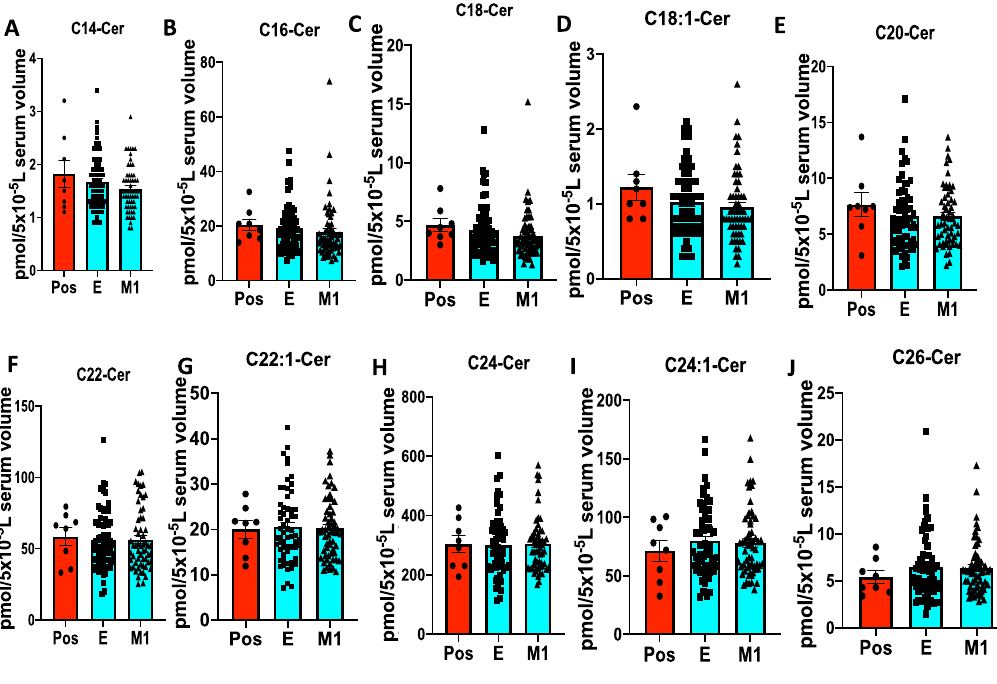
Figure 3. Serum ceramide levels with different fatty acyl chain lengths in COVID-19 longitudinal samples compared to asymptomatic positives. LC–MS/MS ceramide (Cer) measurements for ( A ) C14-Cer, ( B ) C16- Cer, ( C ) C18-Cer, ( D ) C18:1-Cer, ( E ) C20-Cer, ( F ) C22-Cer, ( G ) C22:1-Cer, ( H ) C24-Cer, ( I ) C24:1-Cer, and ( J ) C26-Cer. Pos Asymptomatic Positive antibody test (n = 8), E enrolled at time of diagnosis (n = 60), M1 one month of recovery (n = 59). Data are means of ± SEM, and P < 0.05 is considered